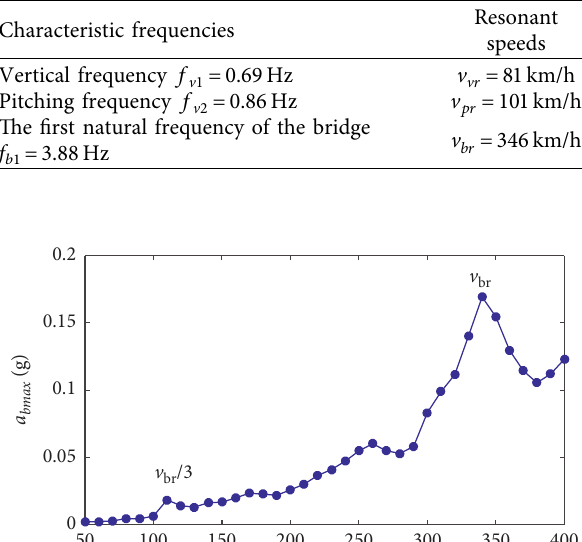
Table 3: Train-induced and bridge-induced resonant speeds.